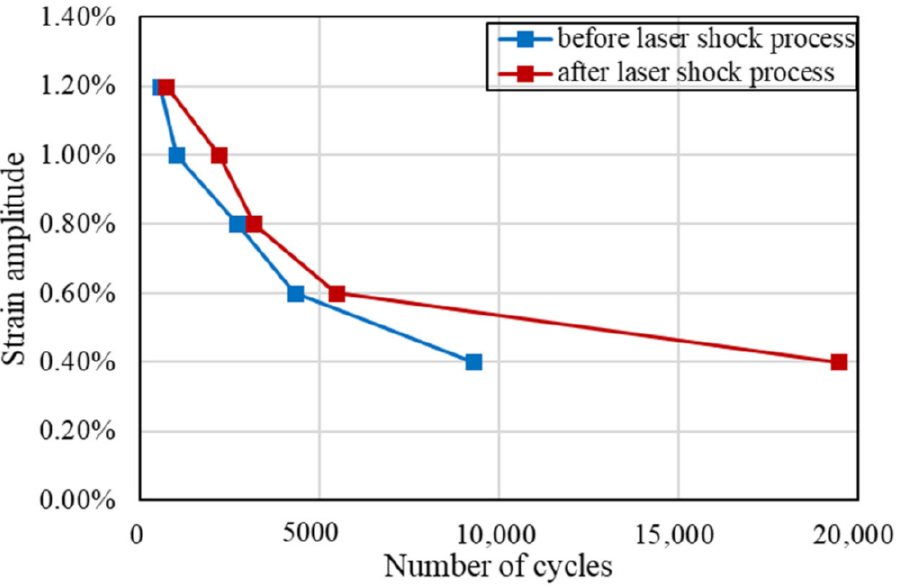
Figure 3. Fatigue life of specimen before and after